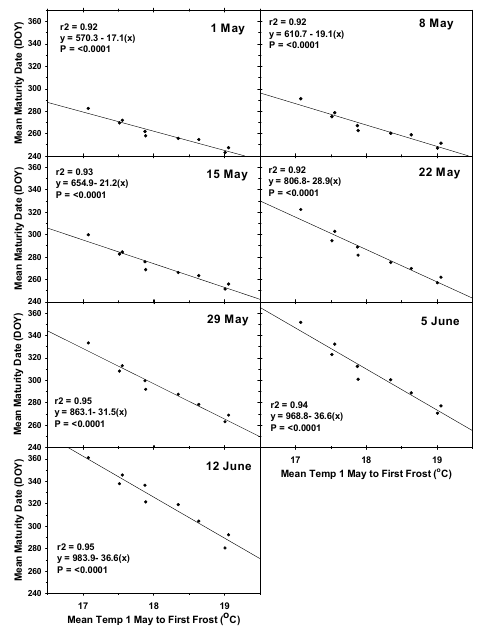
Figure 3. Relationship between mean temperature from 1 May to the mean first frost date and mean maturity date of nine locations in northeastern Colorado for seven planting dates. Dryland (GS) phenological parameters, Early maturity class, and Optimum seedbed water conditions at planting were used for simulating maturity date. If maturity was not predicted by the end of the year, maturity date was set to 31 December. Linear regression lines are given with associated r 2 and probability of significance.